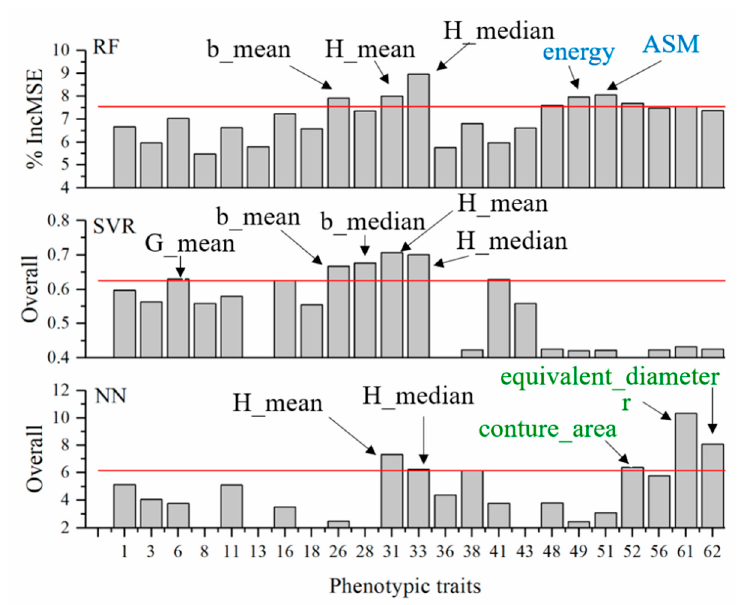
Figure 7. Relative contributions of individual features in predicting nitrogen nutrition index (NNI). Note that the phenotypic features are shared in the three panels. Phenotypic features are indicated in numbers corresponding to their names. The top five most important features are highlighted and labeled; the black, blue, and green fonts represent the color-, texture-, and morphology-related features, respectively.